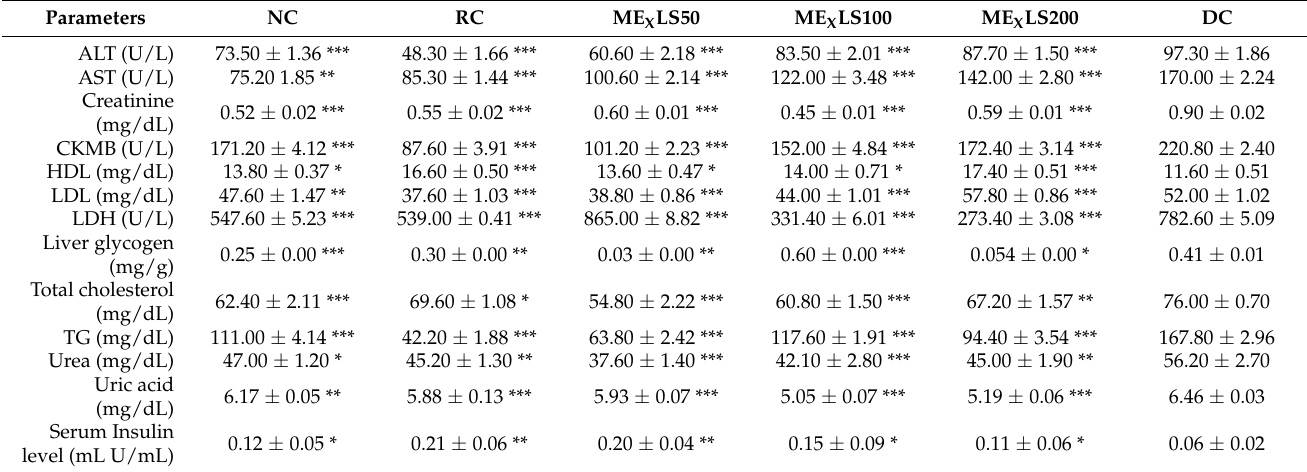
Table 4. Effects of ME X LS on different serum parameters and liver